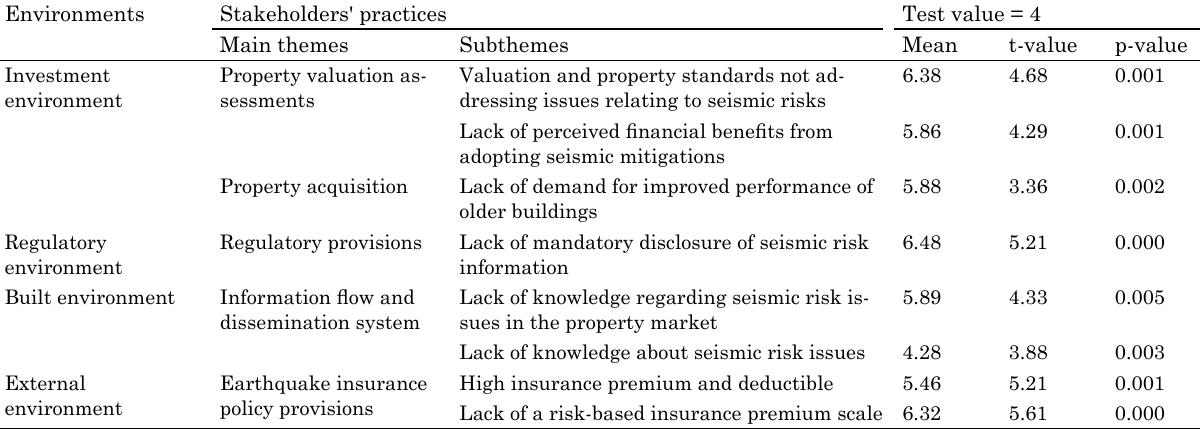
Table 3. Survey results – significant stakeholders practices acting as impediments to earthquake mitigation decisions